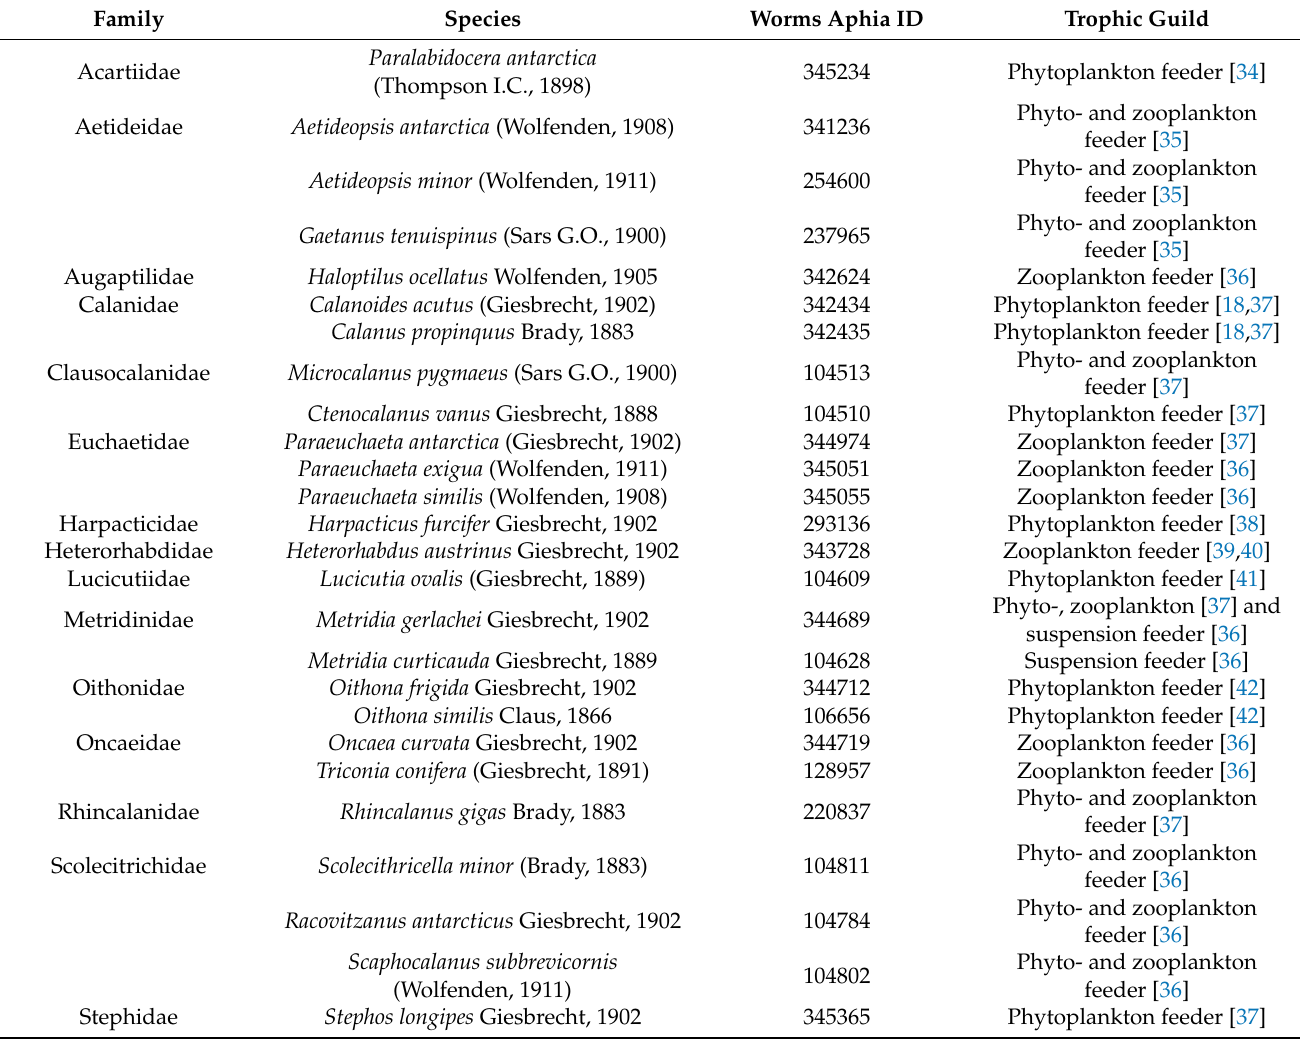
Table 1. Species list. AphiaID from the World Register of Marine Species (WORMS, https://www.